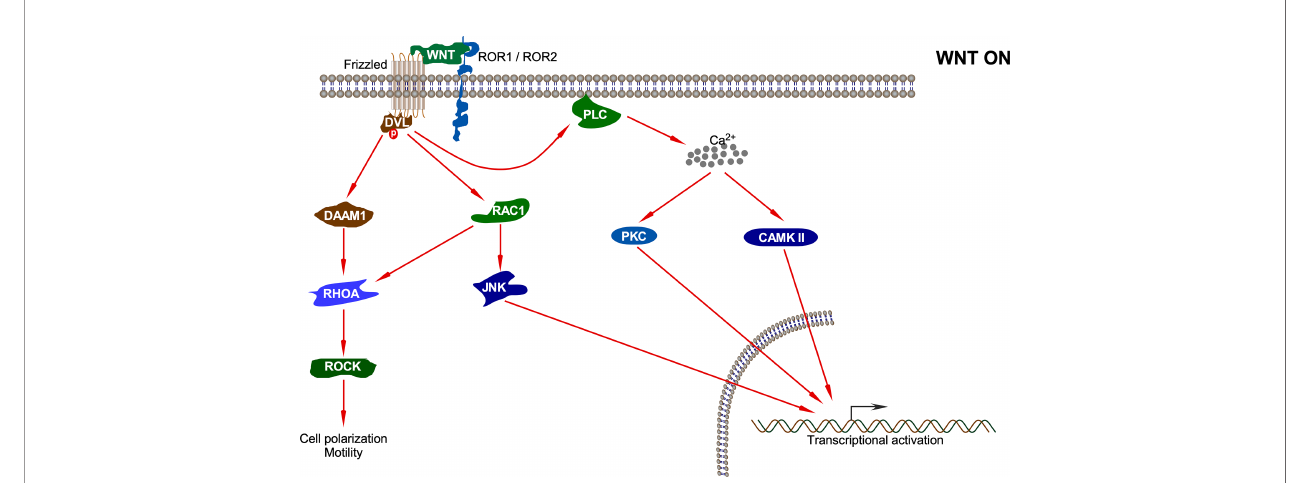
FIGURE 4 | Non-canonical WNT pathway. Upon interaction of the non-canonical WNT ligand with Fz and ROR1/ROR2, several pathways including DAAM1-RHOA- ROCK, RAC1-JNK, PKC, and CAMKII pathways are activated which results in different cellular processes and transcriptional activation of different sets of